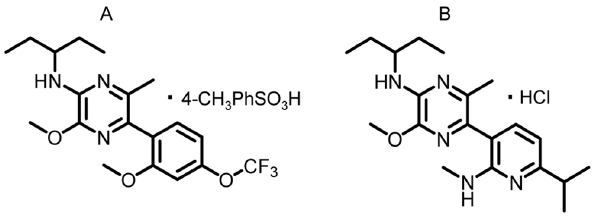
Figure 1. Chemical structures of A=NGD 98-2:5-(2-Methoxy-4- trifluoromethoxyphenyl)-[N-(1-ethyl)propyl]-3-methoxy-6- methylpyrazine-2-amine tosylate. B=NGD 9002:5-(6-isopropyl-2- methylaminopyridin-3-yl)-[N-(1-ethyl)propyl]-3-methoxy-6-methylpyra- zine-2-amine hydrochloride.